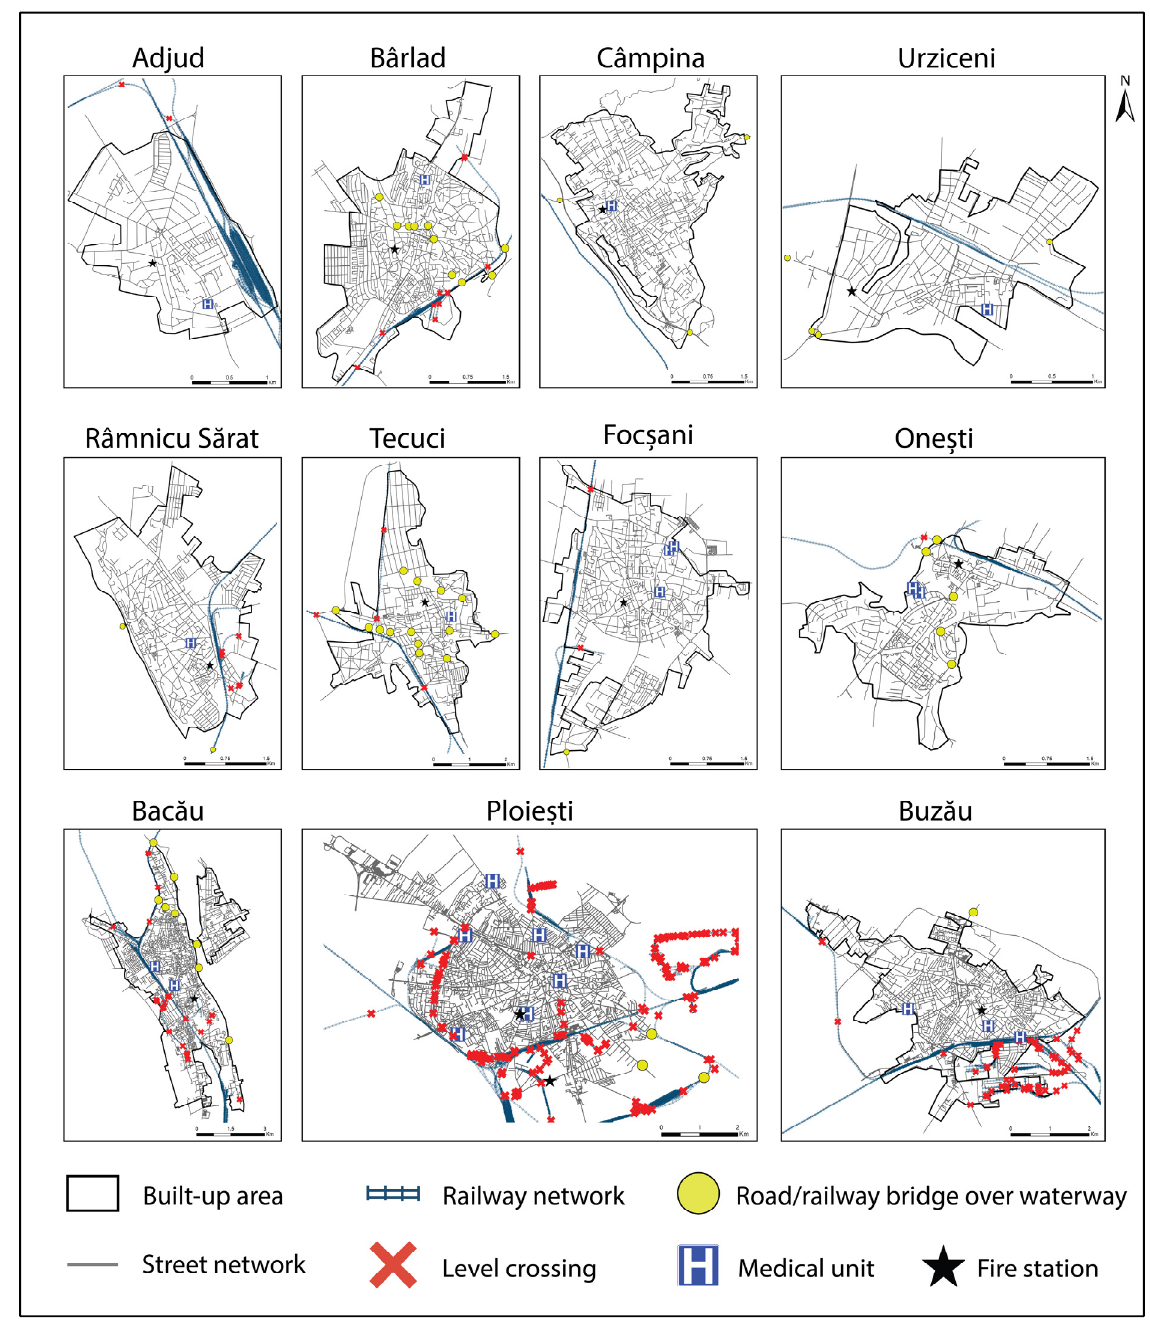
Figure 3. The location of key emergency management facilities and the spatial configuration of the urban street network, in the 11 urban settlements (Data sources: [67]) The scale was adapted for each urban settlement to better portray the urban street network.